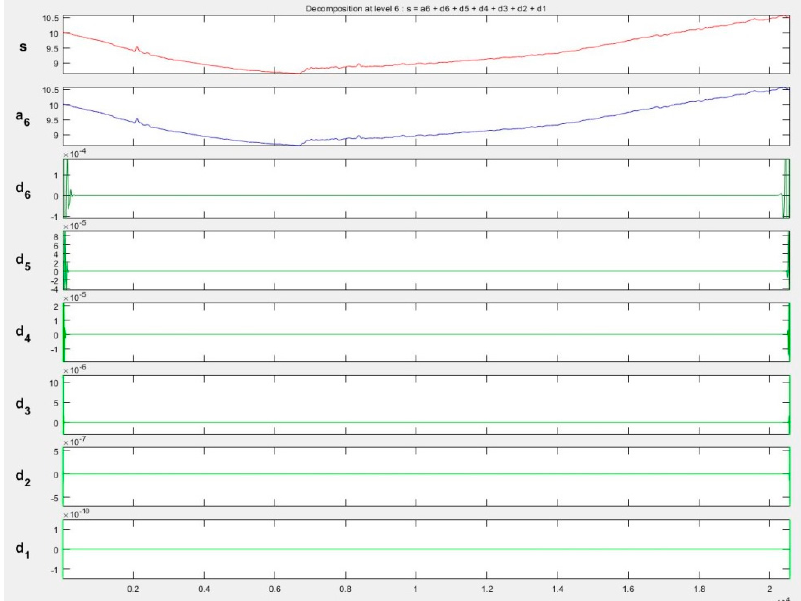
Figure 14. The fragment of decomposition of the Z denoised coordinate with the DB6 L6 wavelet, s—original signal, a—approximation, d1–d6—decomposition details.